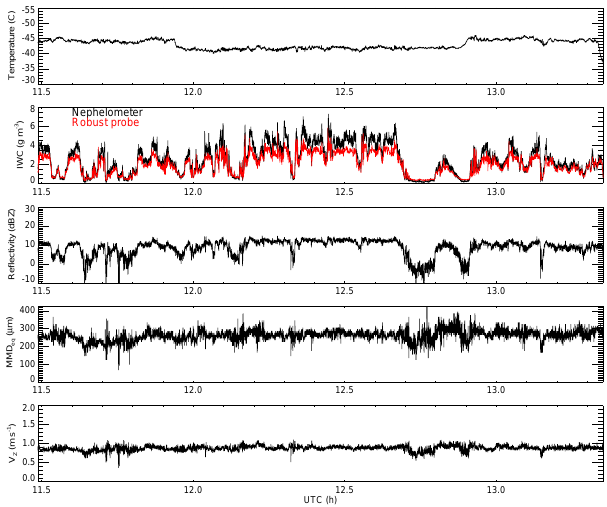
Figure 5. Static air temperature, ice water content (IWC), equiva- lent radar reflectivity ( Z e ), ice mass median area-equivalent diam- eter (MMD eq ), and Z e -weighted fall speed ( V Z ) during Cayenne flight